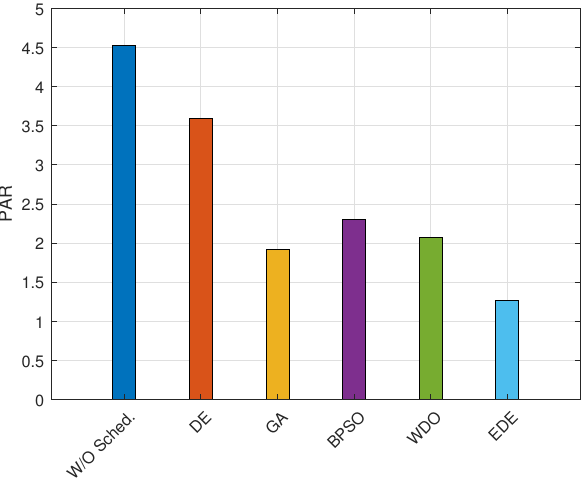
Figure 11. Interruptible appliances PAR evaluation. Table 8. Numerical results of PAR after scheduling interruptible appliances. Scheduling